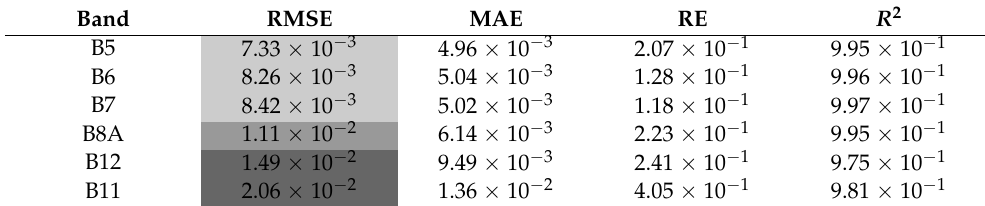
Table 4. Single-band regression results for L2A. The colors in the RMSE (relative error) column indicate whether the specification is fulfilled (light gray), nearly fulfilled (middle gray) or unfulfilled (dark